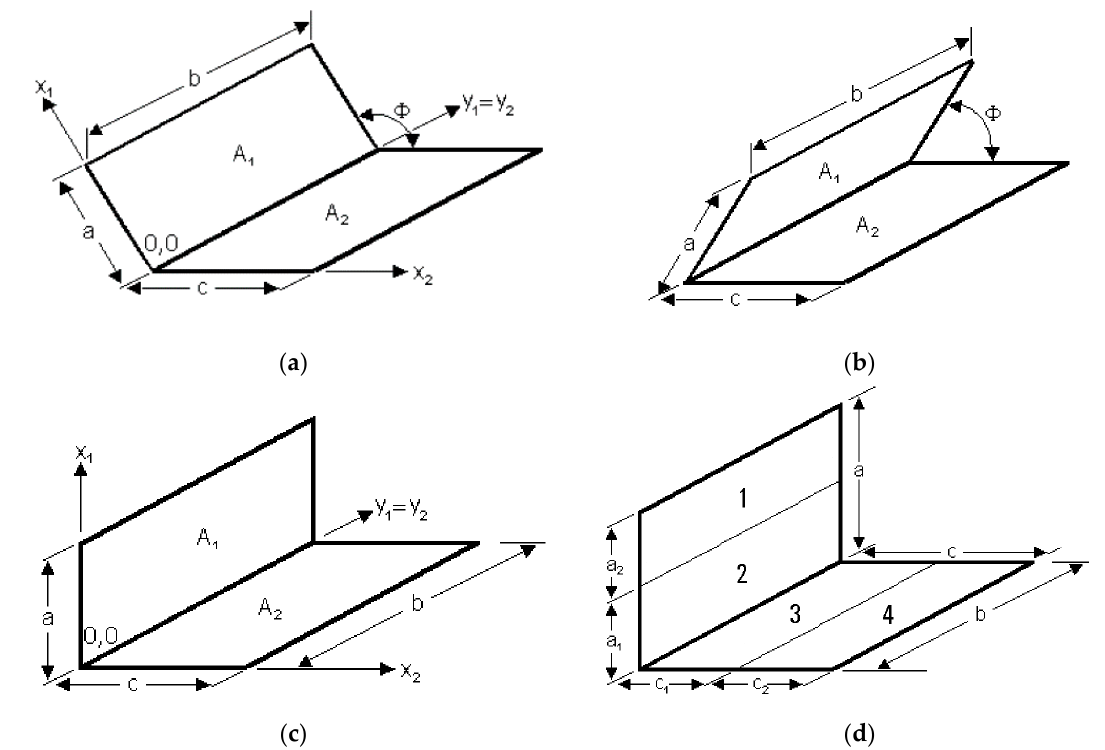
Figure 4. Two plane surfaces separated by an angle Φ : ( a ) co-ordinate system; ( b ) Φ < 90°; ( c ) Φ = 90°; and ( d ) Φ = 90°, split areas.